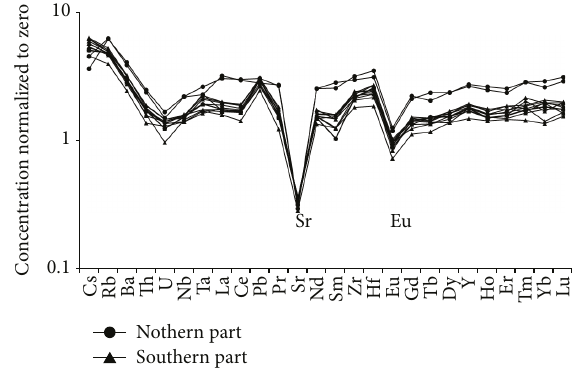
Figure 5: Trace element patterns of Fukano Caldera MIs normalized to Za1011 (Zao basaltic andesite) from Tatsumi et al. [38], showing the similar elemental concentrations of the samples. Depletions of strontium and europium resulting from plagioclase crystallization are